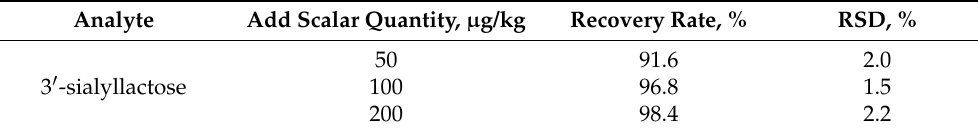
Table 3. Recovery rate and relative standard deviation of 3 (cid:48) -sialyllactose in edible bird’s nest. Table 3 . Recovery rate and relative standard deviation of 3’-sialyllactose in edible bird’s nest. Analyte Add Scalar Quantity, µ g/kg Recovery Rate, Analyte